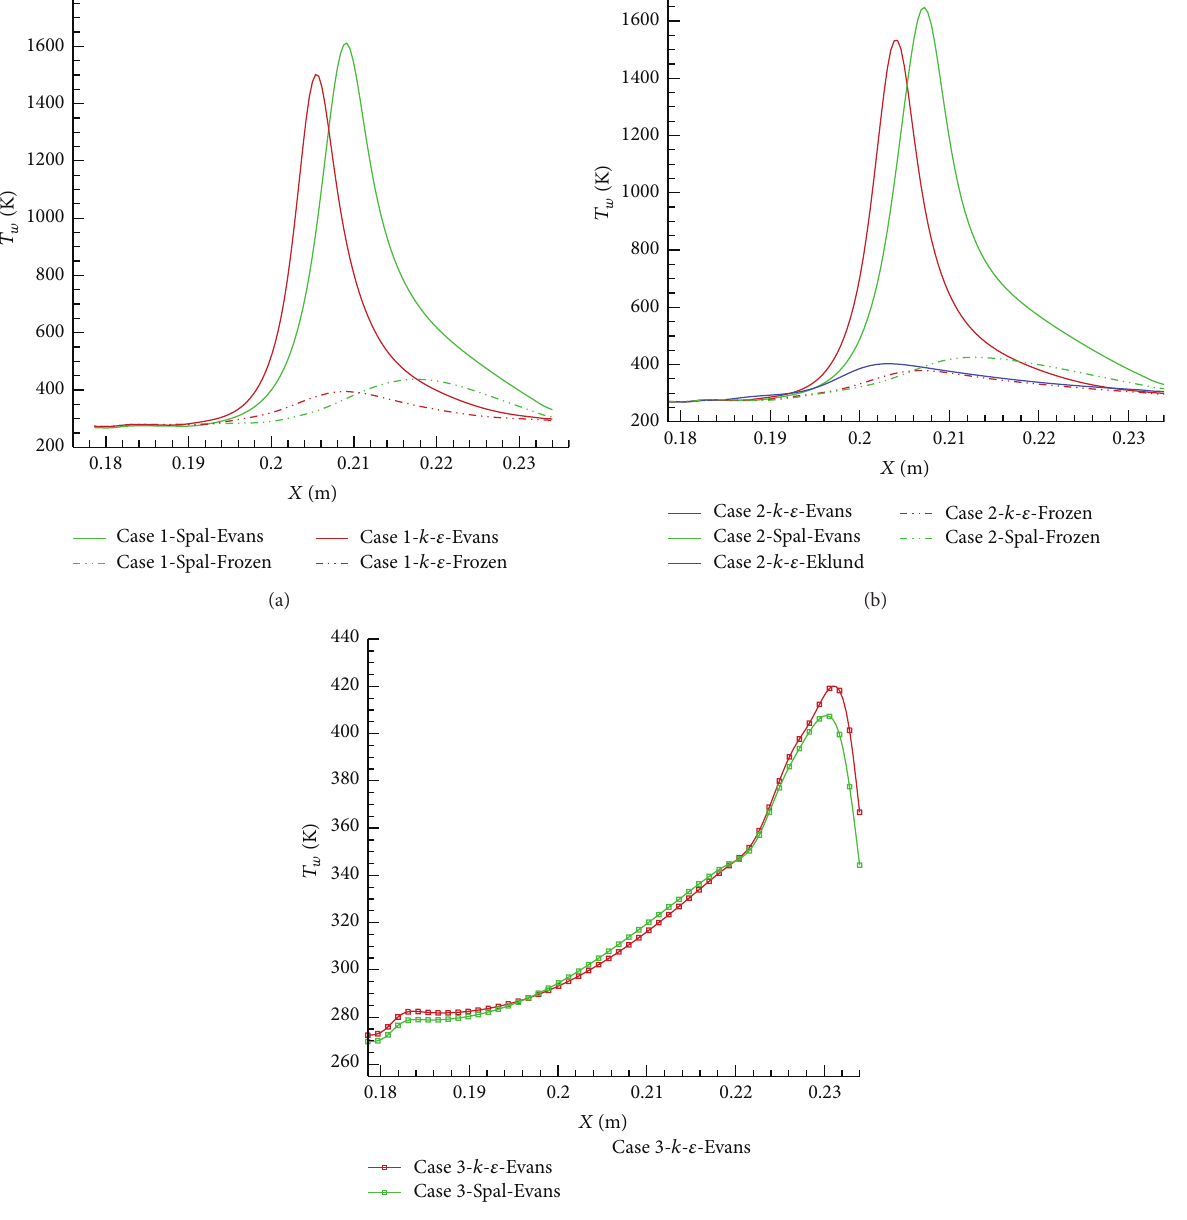
Figure 11: Wall temperature profiles with reignition, Cases 1 (a) and 2 (b), and without reignition for Case 3